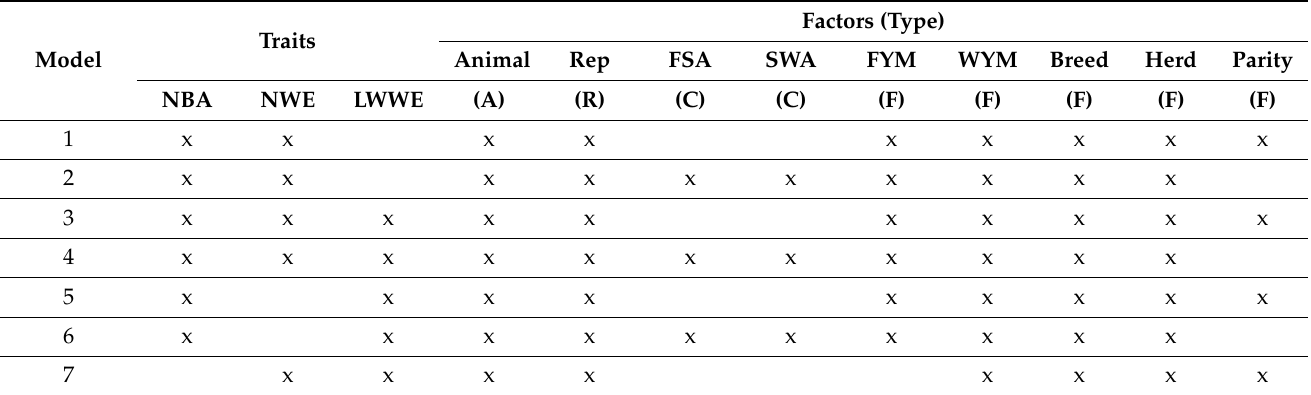
Table 2. The structure of the applied animal models.